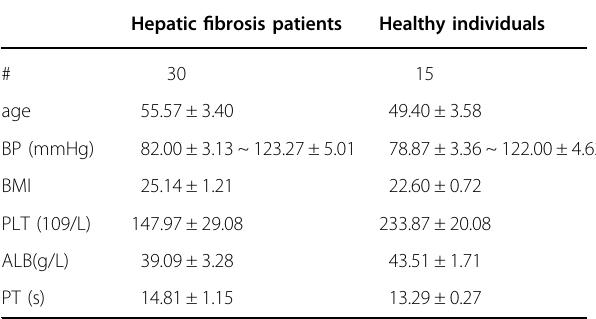
Table 1 Demographic and clinical characteristics of hepatic fi brosis patients and healthy individuals.